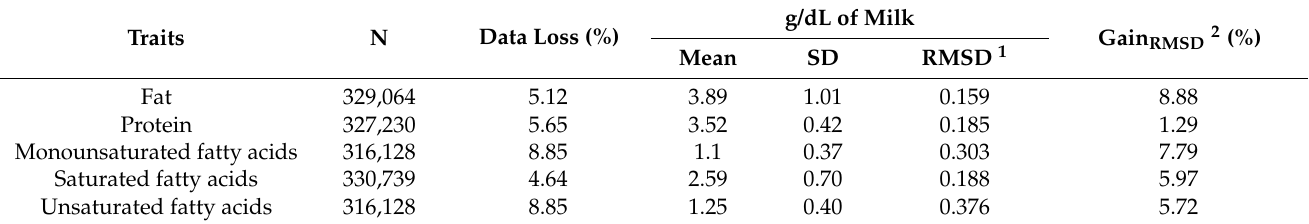
Table 5. Characteristics of the dataset obtained after a cleaning based on a Global-H (GH) distance set at 5 (Method 2). Traits